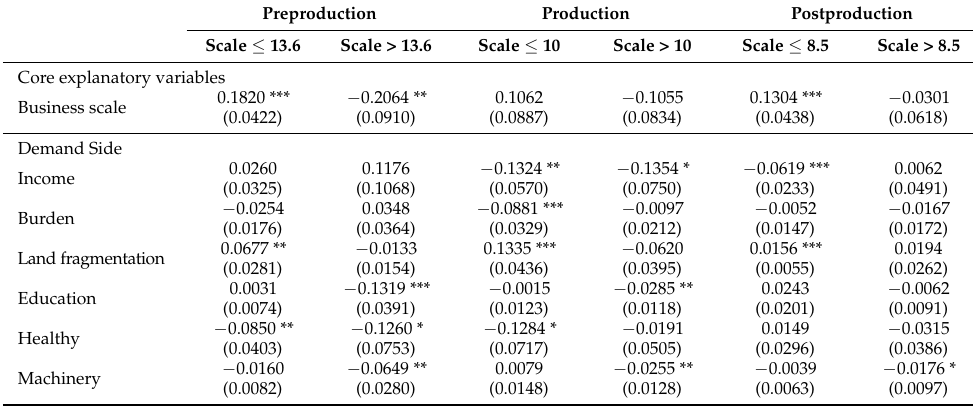
Table 7. Heterogeneous effects of different production